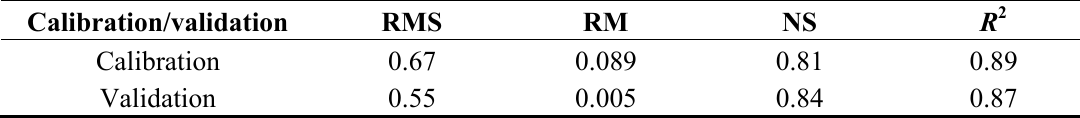
Table 6. Statistical analysis for model